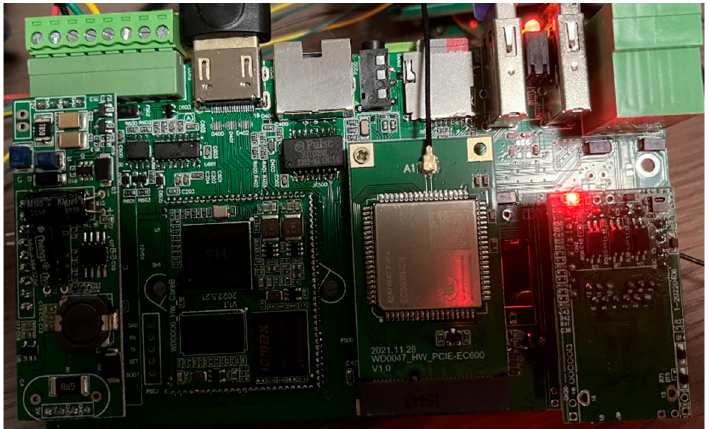
Figure 9. The PCB layout design of an Android-based board, used by EMULSION.